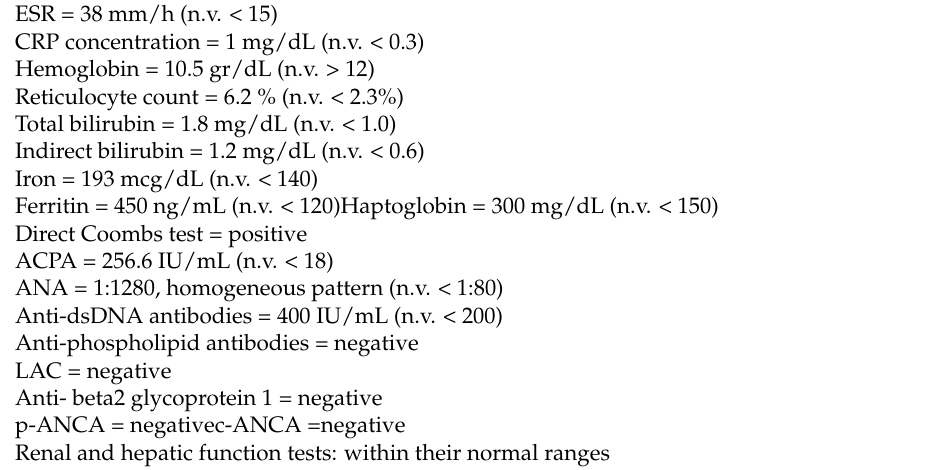
Table 2. The patient refused genetic assessment. Table 2. Main laboratory data at the time of our examination.